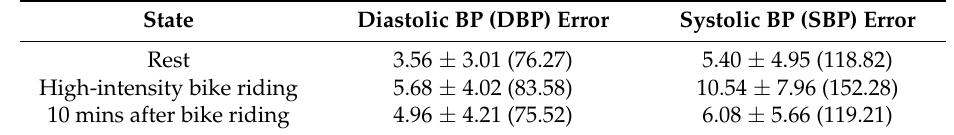
Table 2. Averages and errors of the estimated BPs for participants who engaged in high-intensity bike